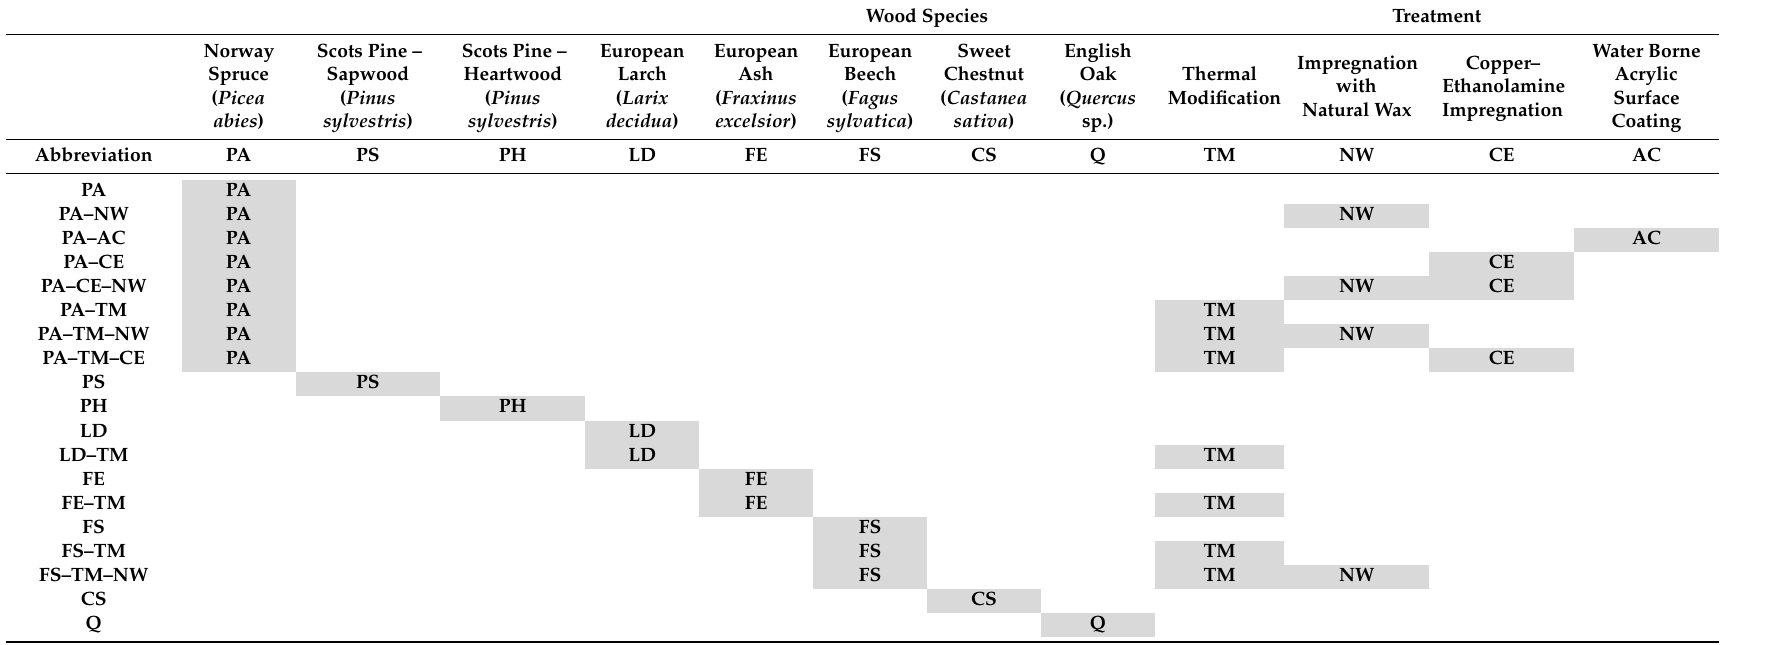
Table 1. Nineteen di ff erent investigated wood species and wood-based